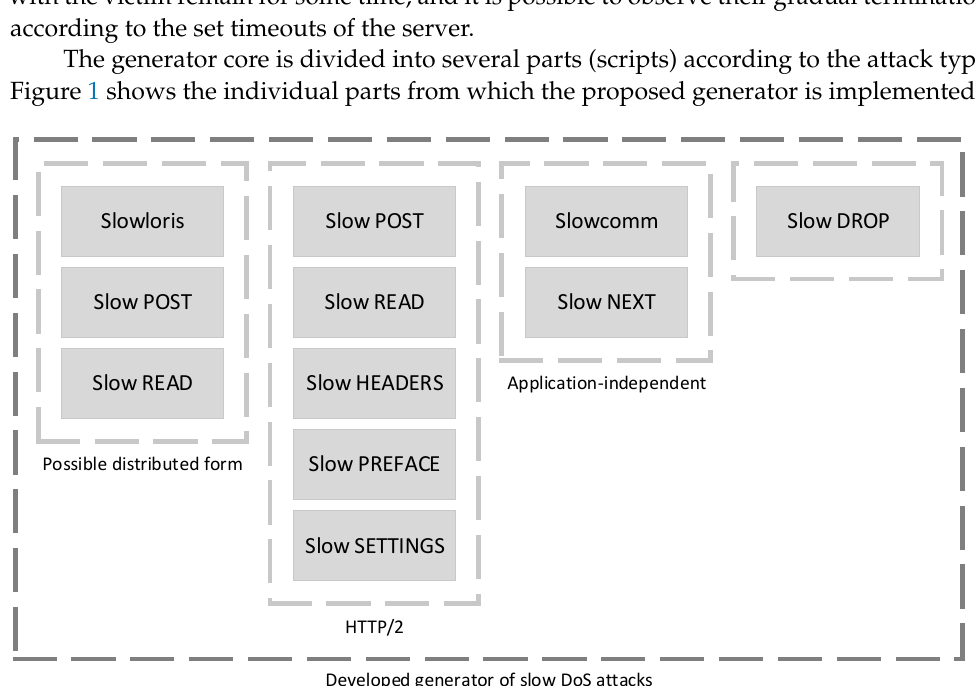
Figure 1. Individual parts of implemented slow DoS